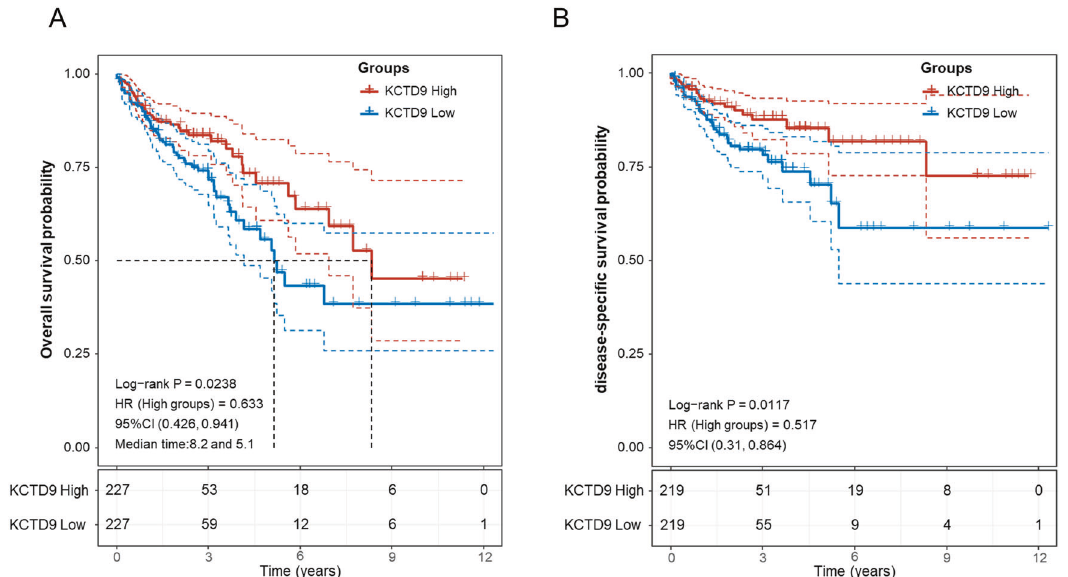
Fig. 2 Downregulation of KCTD9 expression is correlated with disease progression and prognosis. A , B Kaplan-Meier analysis and log-rank test for CRC patients from the TCGA-COAD dataset strati fi ed according to median KCTD9 expression levels. Cases with low KCTD9 expression were associated with signi fi cantly poorer overall survival (OS) ( A ) and disease-speci fi c survival (DSS) ( B